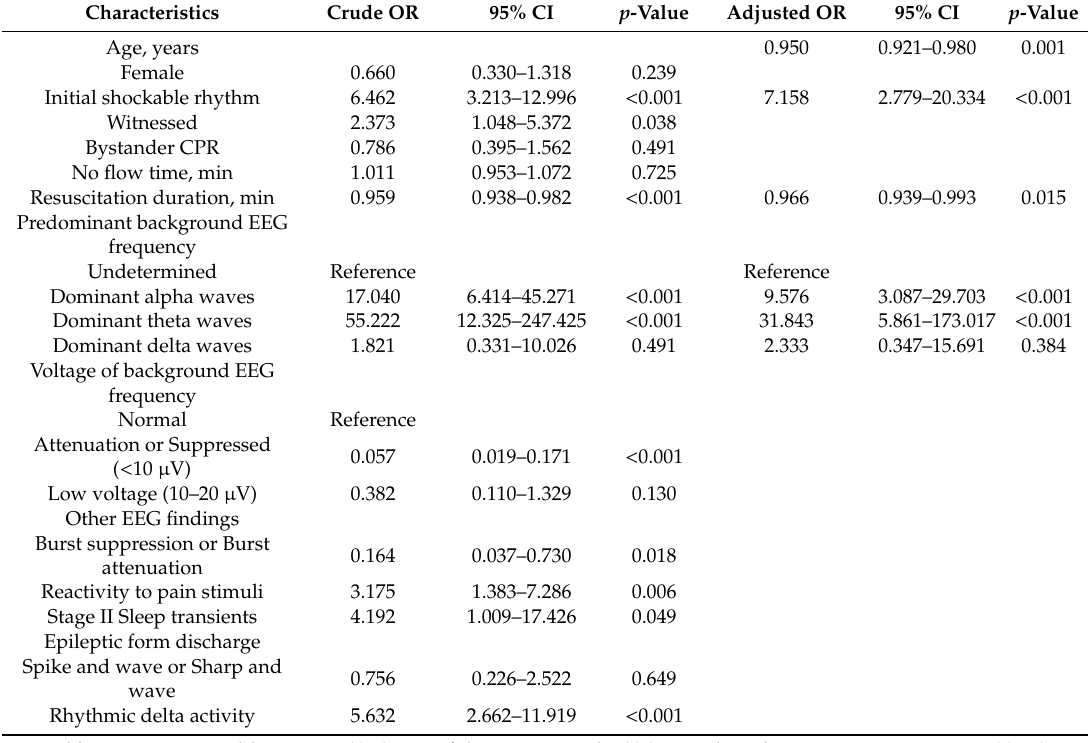
Table 3. Univariate and multivariate logistic regression analysis for a 6-month favourable neurologic